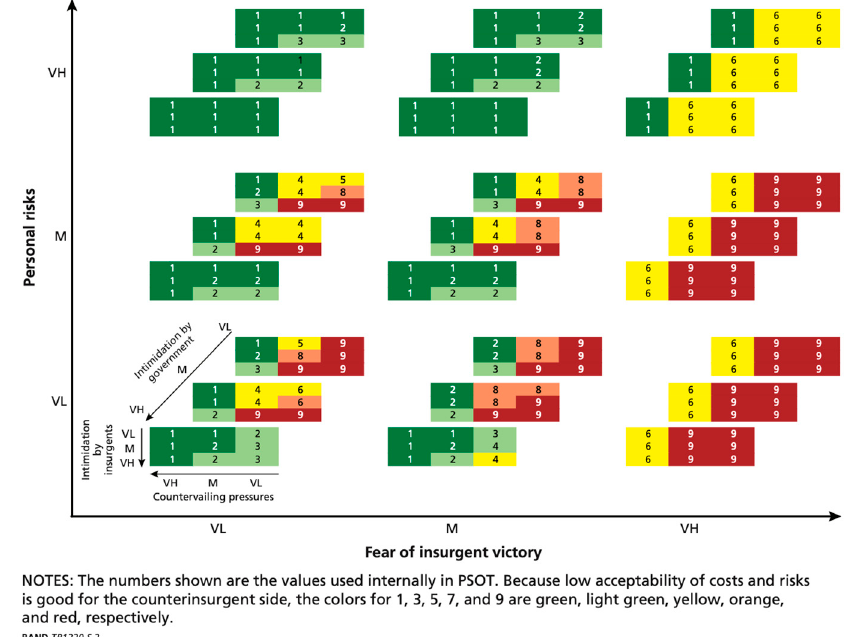
Figure 9. Summary results for a computational model built from Figure 8.